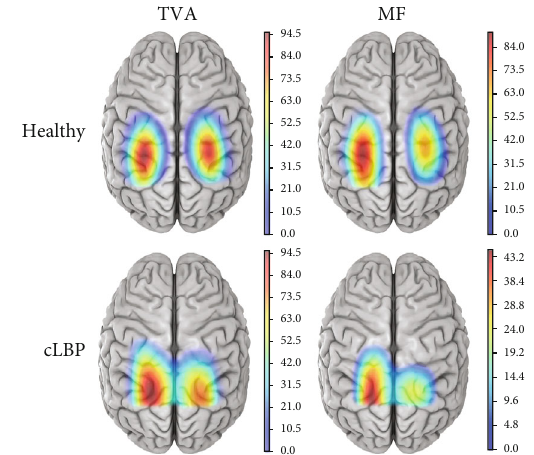
Figure 2: Average representative location of TVA and MF responses to TMS for the healthy and cLBP groups on the left and right hemispheres. cLBP: chronic low back pain; L: left; R: right; TVA: transversus abdominis; MF: multi fi dus; CoG: center of gravity. Note: this fi gure was generated from the average data of all the patients. The posterior aspect of the map appeared to be not recorded fully over the entire cortical representation of the muscle. This was due to two cortical motor maps of cLBP patients located more posteriorly. The CoG of TVA and MF from all other participants ’ muscles in cLBP patients were within the region of the grid